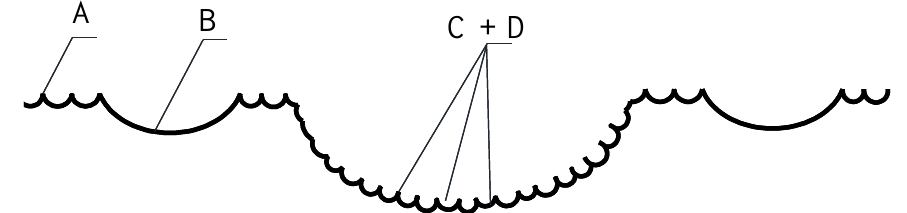
Figure 6. 2-D scheme of the identified dimples and their classification: A—individual dimples (small- and medium-sized); B—large dimples; C + D—large dimples (C), the surface of which is decorated with small dimples (D).